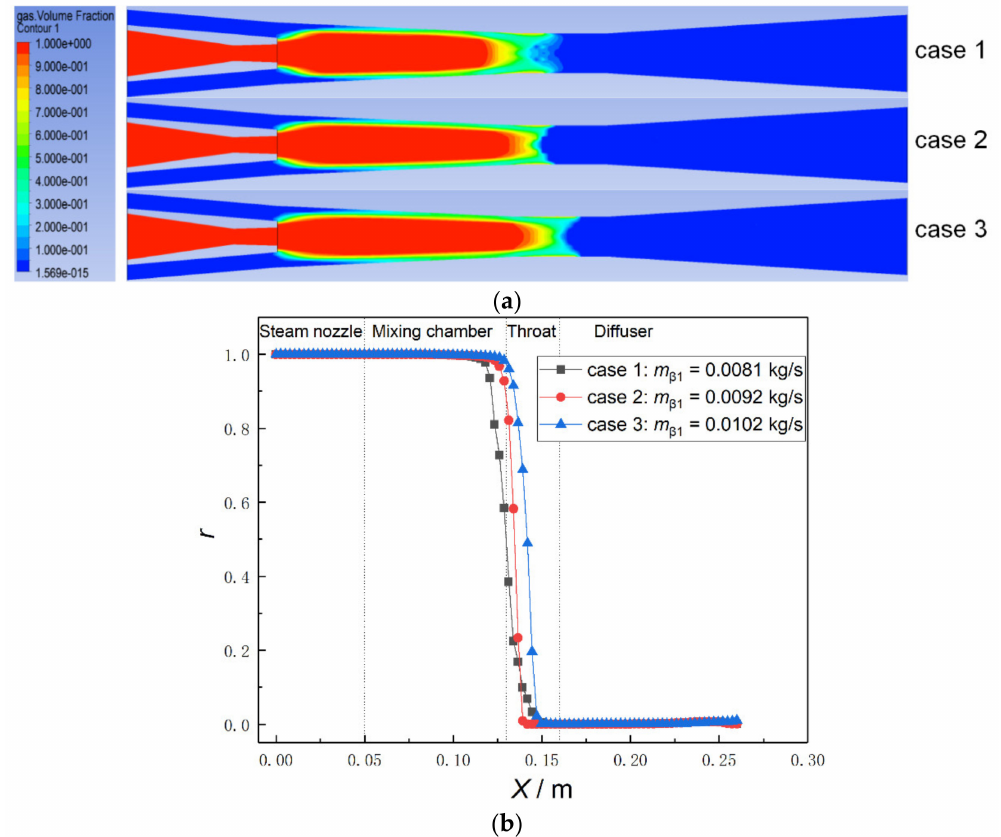
Figure 7. Effect of steam inlet mass flow rate m β 1 on steam volume fraction. ( a ) Contours of steam volume fractions at different steam inlet mass flow rates; ( b ) Axial profiles of steam volume fractions at different steam inlet mass flow rates.